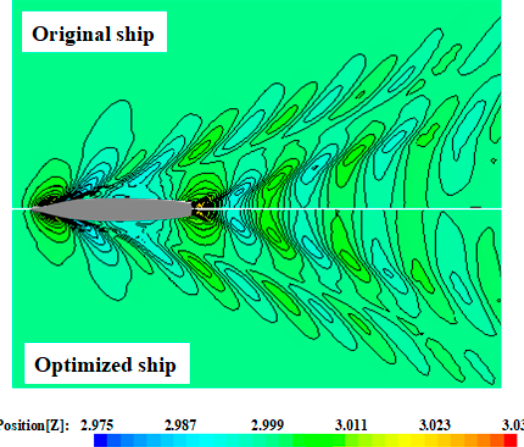
Figure 15. The wave patterns for different ship models.